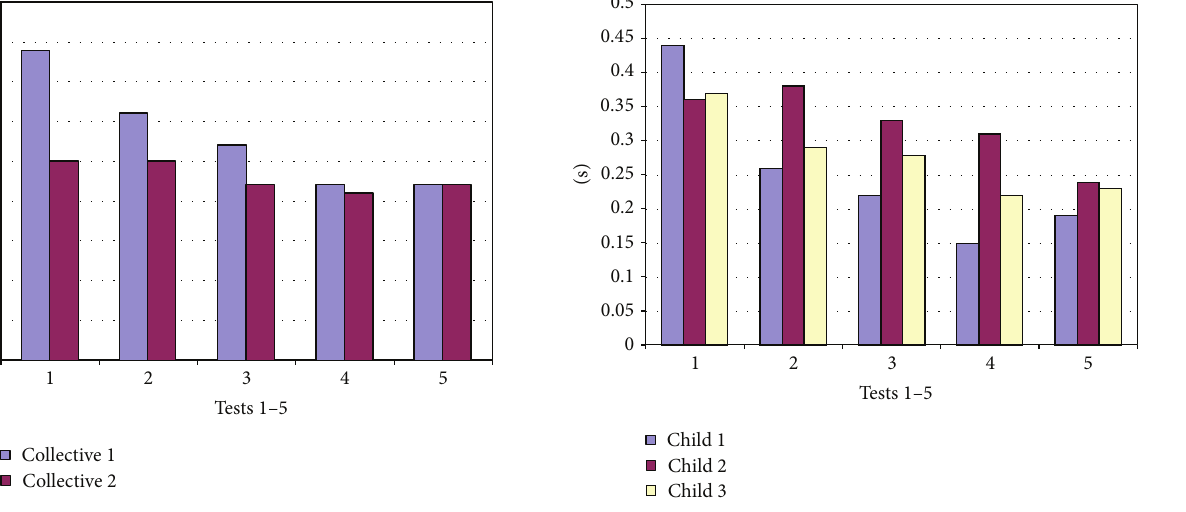
Figure 4: Deviation from the optimal inspiration moment in seconds for child 1 (regularly crying), child 2 (sleeping), and child 3 (sporadically crying) in test 1 before training and in tests 2 to 5 after training in collective